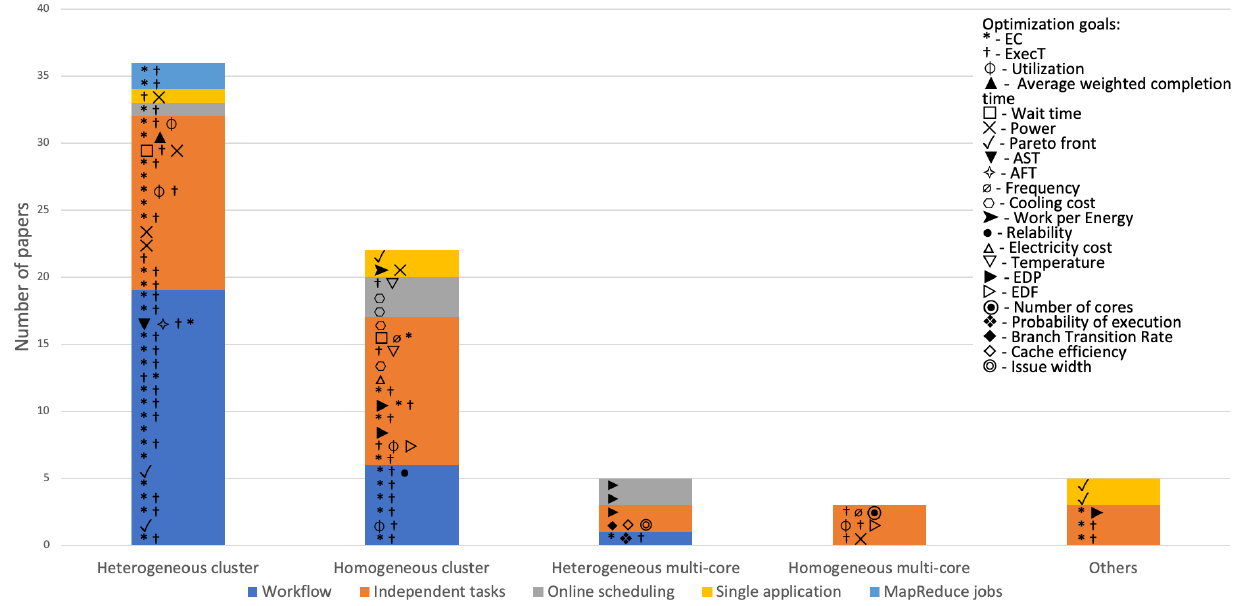
Figure 1. Analyzed papers with scheduling